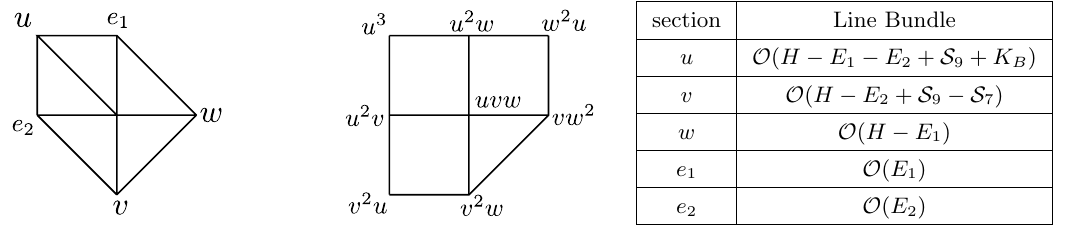
Figure 3 . The polytope F 5 and its dual. The table on the right contains the divisor classes of the coordinates in P F 5